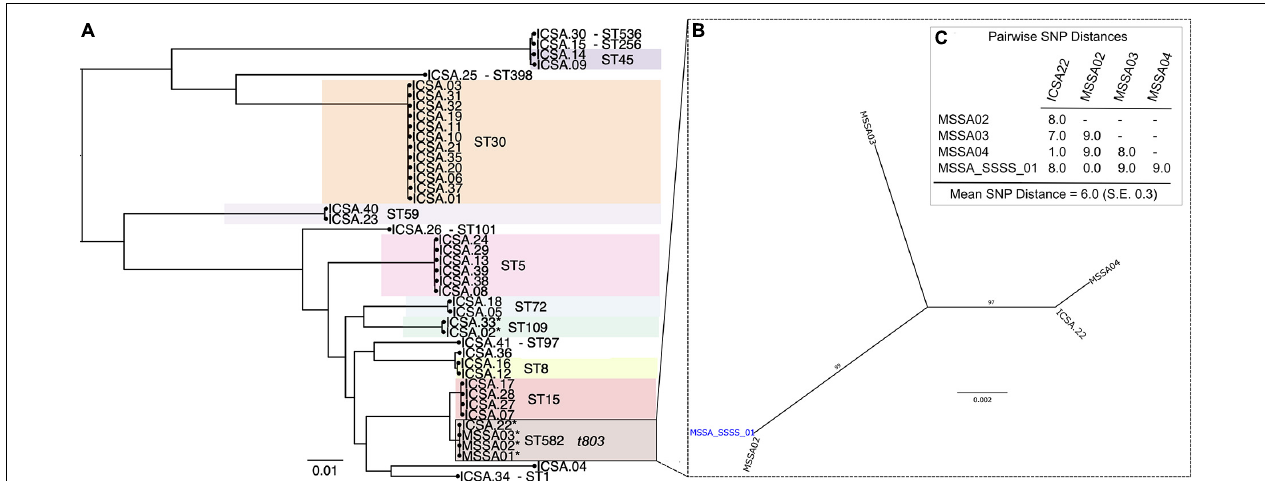
FIGURE 1 | Phylogenetic analysis of methicillin-susceptible Staphylococcus aureus isolates from colonized healthcare workers (ICSA strains) and clinical cases of staphylococcal scalded skin syndrome (SSSS) (MSSA01–MSSA04). (A) Maximum likelihood (ML) phylogeny of 41 carriage isolates inferred from a core genome alignment of 1,989 genes totaling 1,855,652 and containing 80,495 single-nucleotide polymorphisms (SNP), indicating multilocus sequence type (ST). (B) ML phylogeny of four clinical SSSS isolates and a single related healthcare worker carriage isolate. Whole-genome sequencing data were mapped to the closed MSSA_SSSS_01 reference genome. (C) Pairwise SNP distances of isolates included in the phylogeny shown in panel (B)